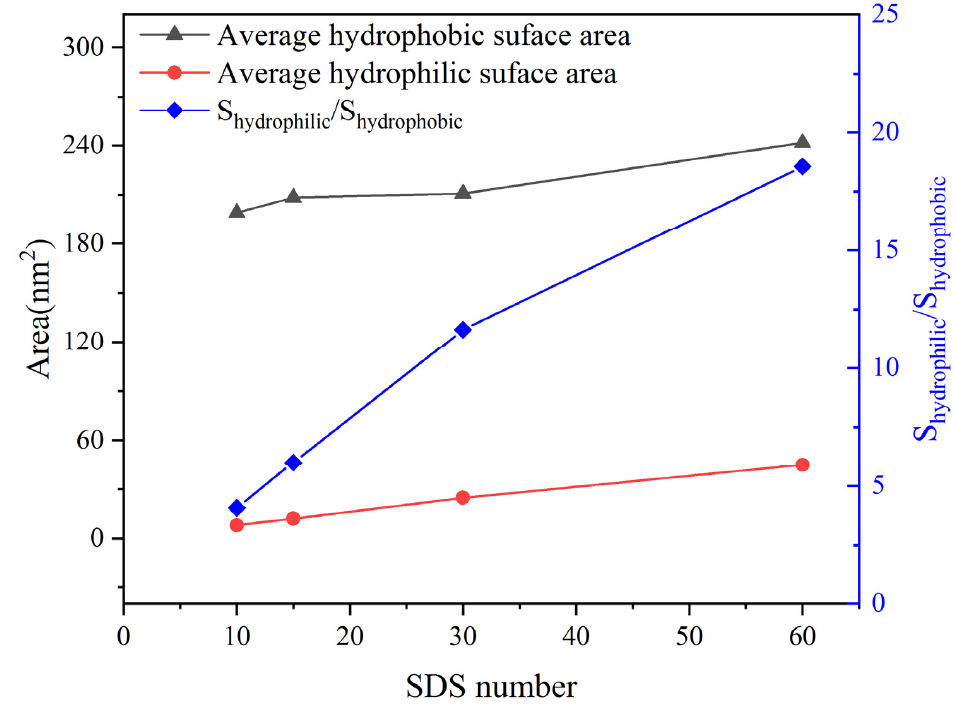
Figure 1. Average hydrophobic and hydrophilic surface areas of emulsified oil droplet.